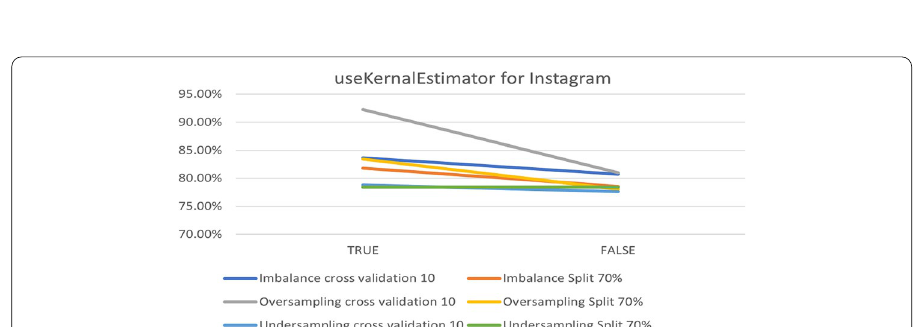
Fig. 13 The accuracy of useKernalEstimator for NB in Instagram